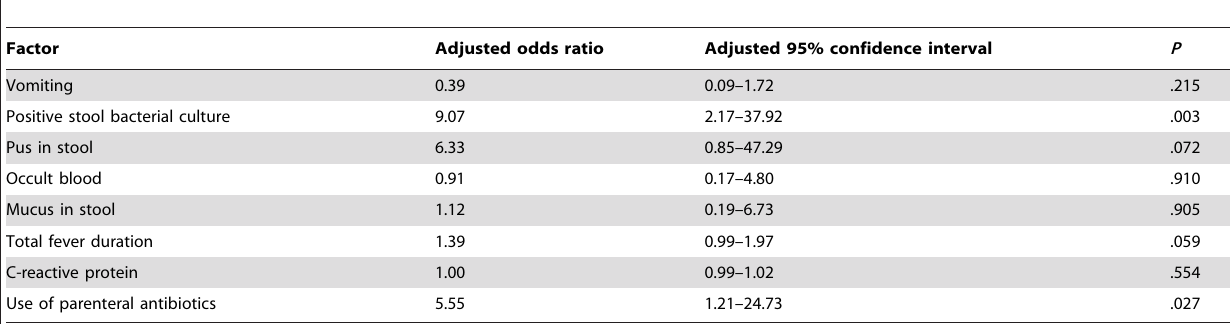
Table 2. Factors associated with false-positive results in the laboratory diagnosis of norovirus infection using RT-PCR targeting the RdRp gene, as determined by multiple logistic regression